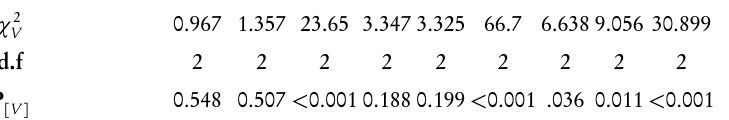
OF, EF, MLE, SEs, 95% CIs, χ 2